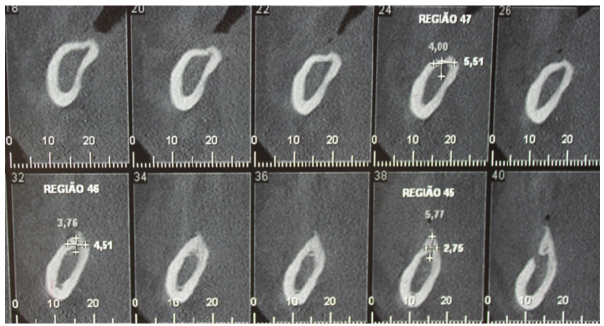
intra- and extraorally, following the inferior alveolar nerve path on the right and left sides.